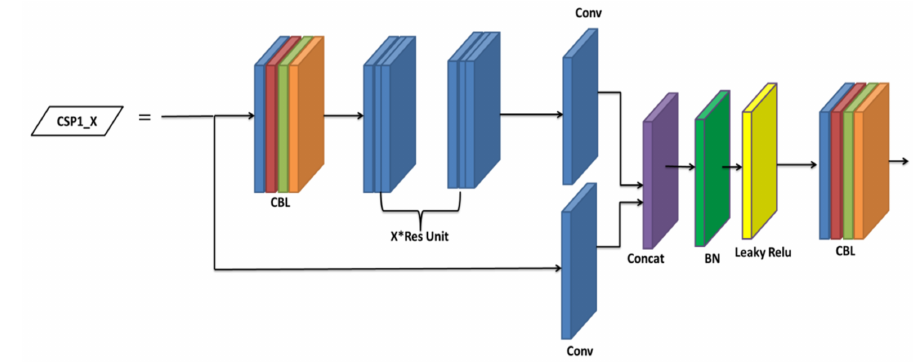
Figure 5. Architecture of the CSP1_X